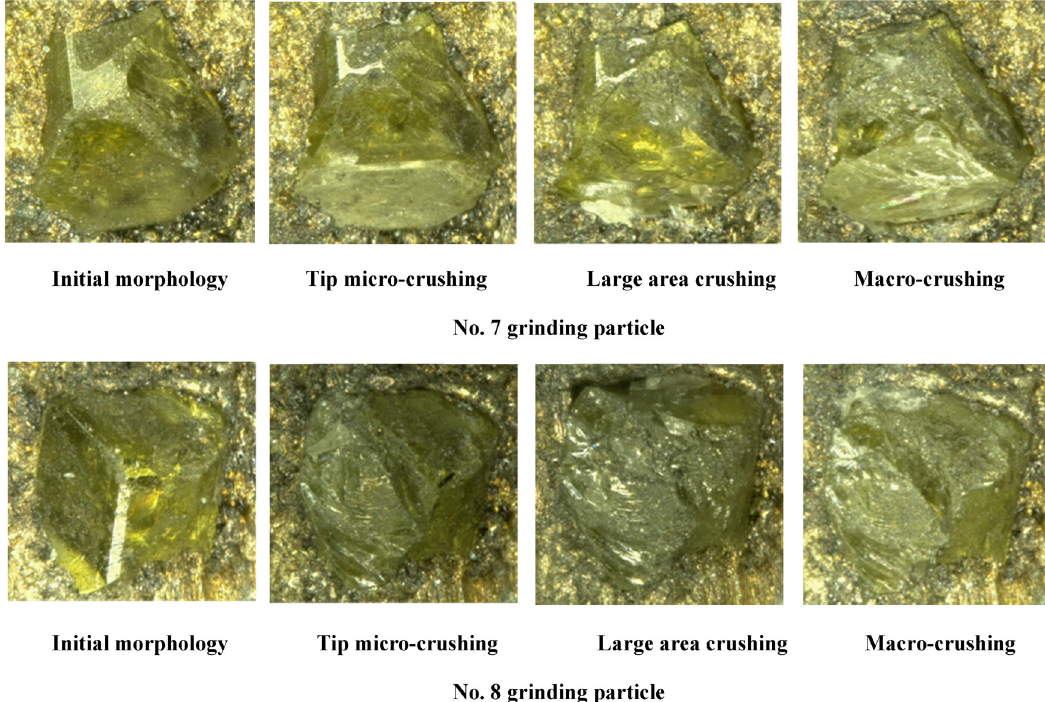
Figure 8: The morphology of the fourth group of abrasive particles. No. 7 grinding particle and No. 8 grinding